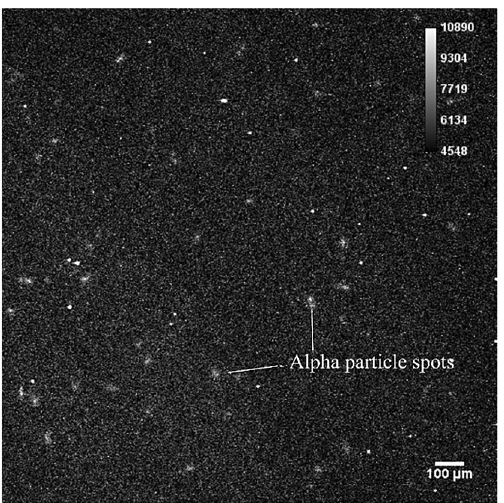
Figure 6. Alpha particles emitted from the 222 Rn progeny with a zoom range of 5 × using the 30-min acquisition.